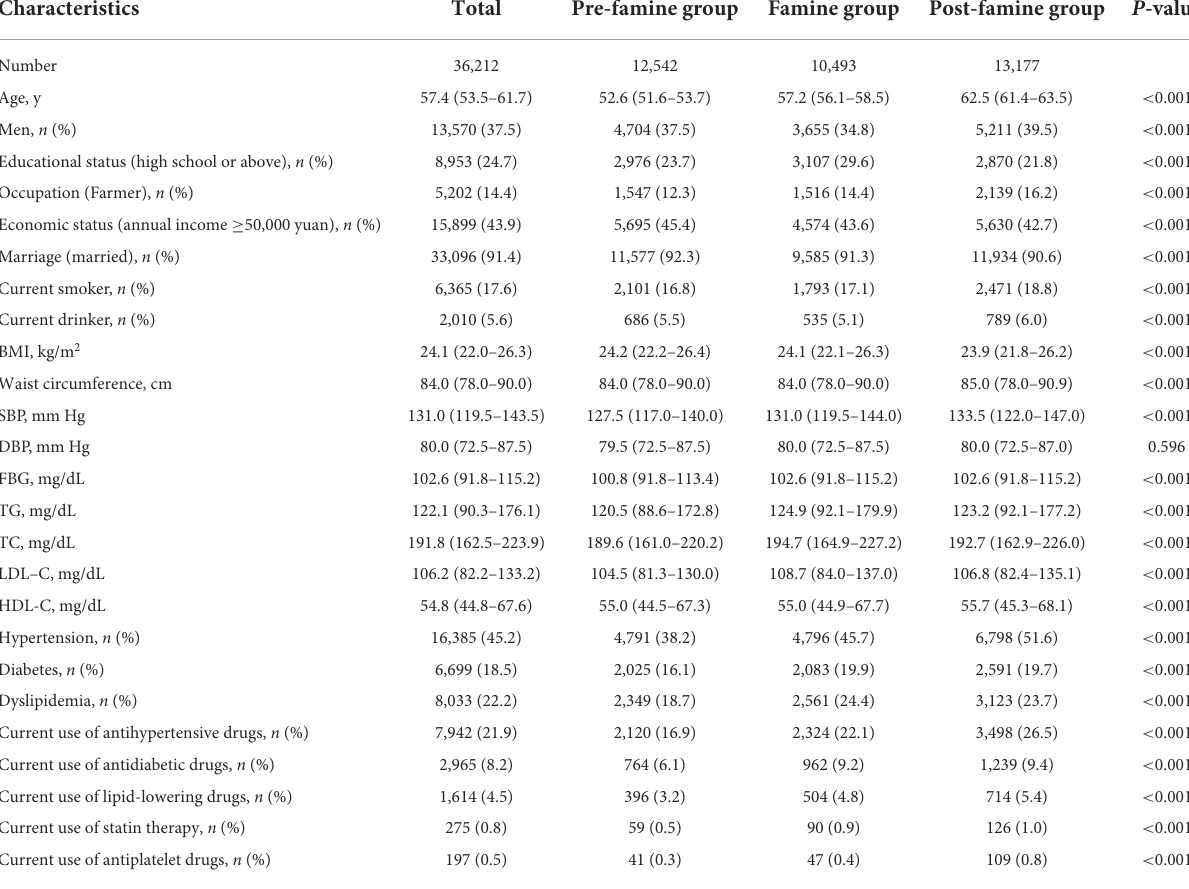
TABLE 1 Characteristics of study participants according to famine exposure among 36,212 participants. Characteristics Total Pre-famine group Famine